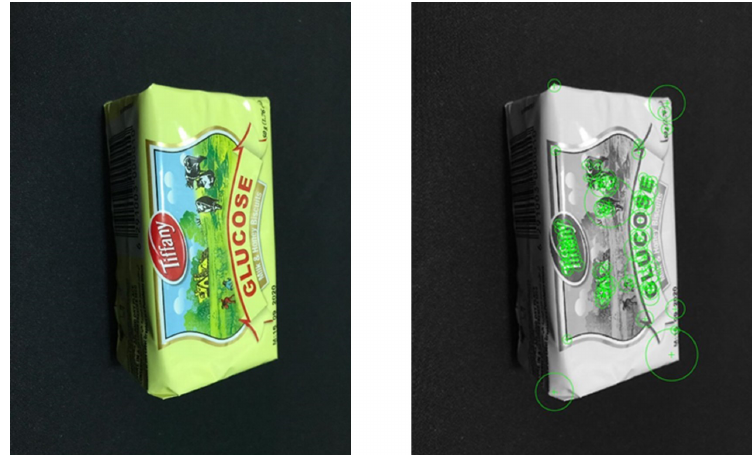
Figure 18. SURF features extraction of another